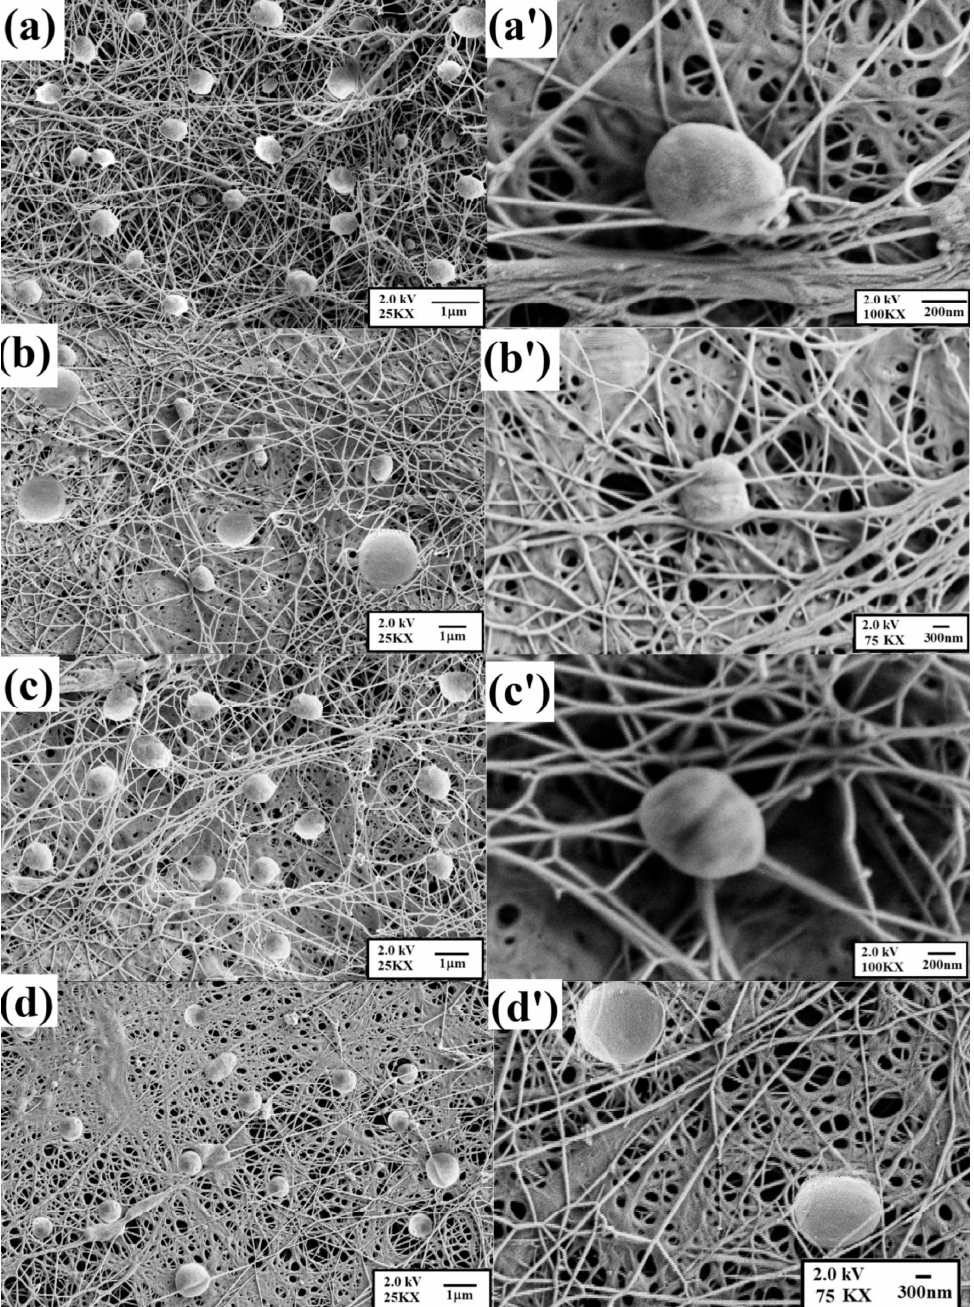
Figure 26. Low ‐ and high ‐ magnification SEM micrographs of ( a , a’ ) BC ‐ PLA 1.5 ‐ Pol 5.0 , ( b , b’ ) BC ‐ Figure 26. Low- and high-magnification SEM micrographs of ( a , a’ ) BC-PLA 1.5 -Pol 5.0 , ( b , b’ ) BC- PLA 1.5 ‐ Pol 2.5 , ( c , c’ ) BC ‐ PLA 3.0 ‐ Pol 5.0 , and ( d , d’ ) BCPLA 3.0 ‐ Pol 2.5 [210] . PLA 1.5 -Pol 2.5 , ( c , c’ ) BC-PLA 3.0 -Pol 5.0 , and ( d , d’ ) BCPLA 3.0 -Pol 2.5